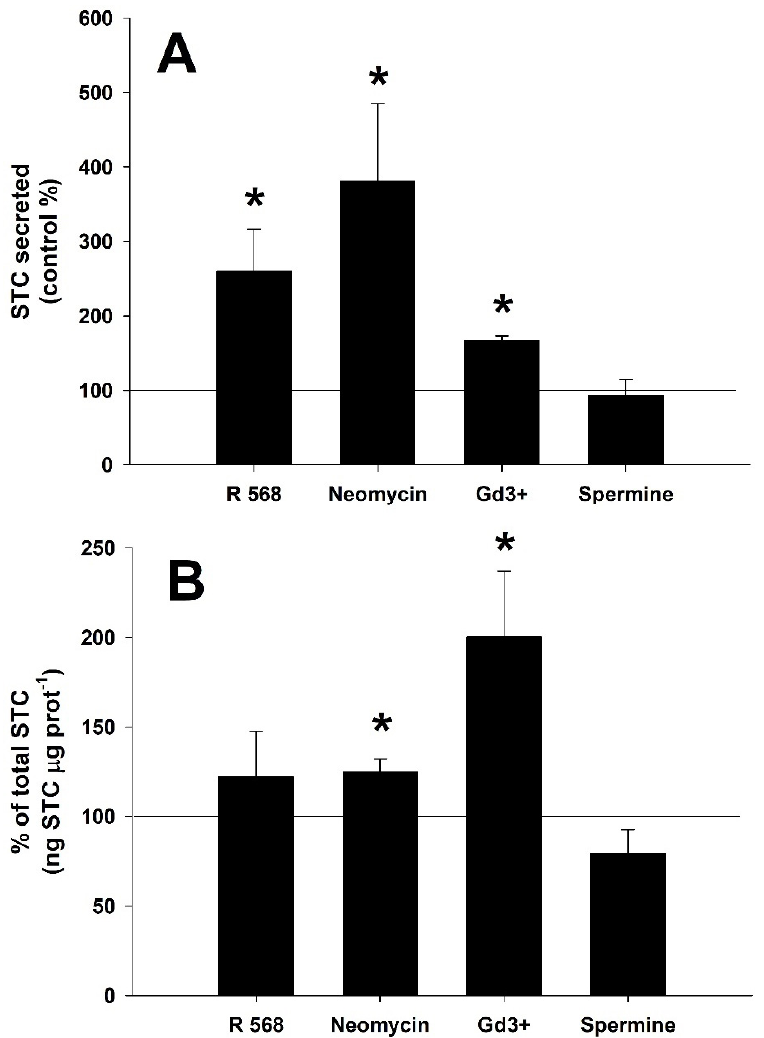
Figure 4. Stanniocalcin (STC) ex vivo secretion ( A ) and production ( B ) from the corpuscles of Stannius of the gilthead seabream, Sparus aurata , after treatment with different calcium-sensing receptor (CaSR) putative agonists: 1 µ M R-568, 200 µ M neomycin, 500 µ M gadolinium (Gd 3+ ) and 500 µ M spermine. Basal STC secretion for the control group is 0.16 ± 0.03 ng STC µ g prot − 1 h − 1 ( n = 24). Values are presented as % of the control group (horizontal line) for single independent experiments (mean ± SEM, n = 6 per group). Asterisks (*) indicate significant differences from the control group (Student ´ s t -test, p <